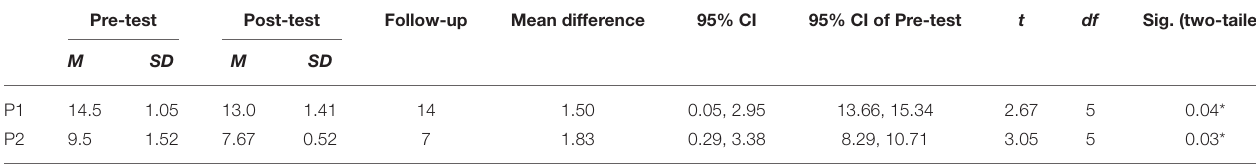
TABLE 1 | Descriptive statistics and t -test results for Albert’s test in participant 1 and participant 2.